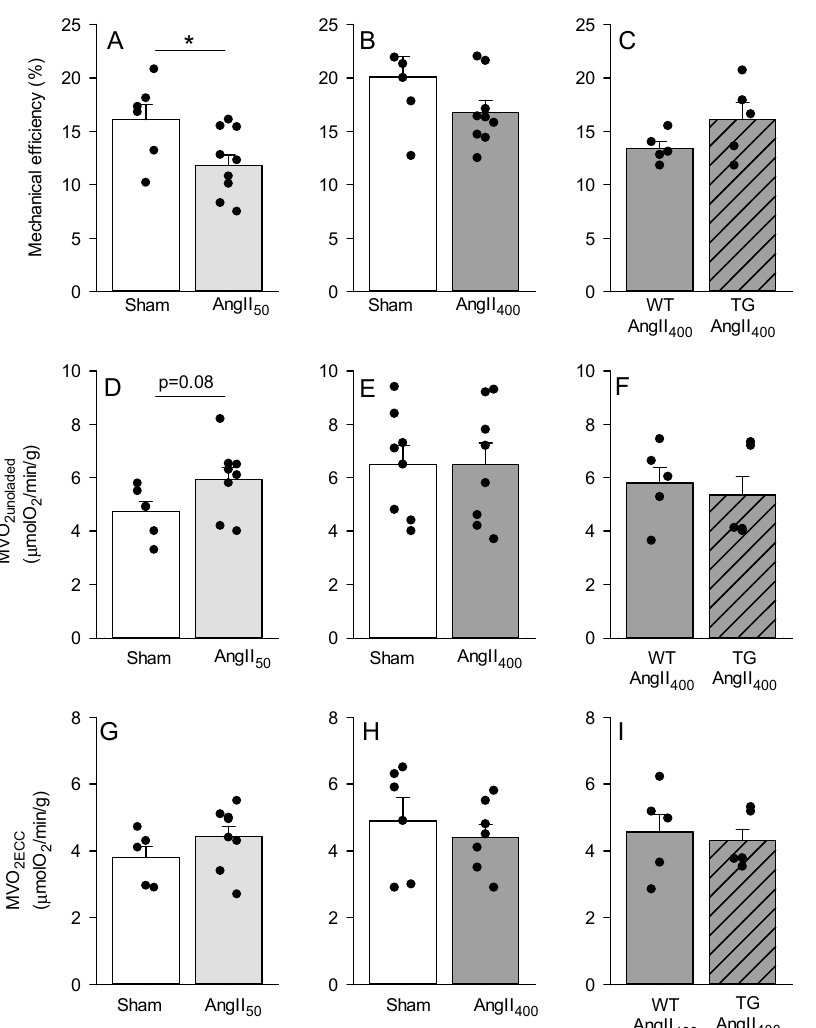
Figure 1. Mechanical efficiency ( A–C ), myocardial oxygen consumption in mechanically unloaded hearts (MVO 2unloaded , D–F ) and MVO 2 for processes associated with excitation-contraction coupling (MVO 2ECC , G–I ), measured in isolated perfused hearts from C57BL/6J, wild-type (WT), and csNOX2 transgenic (TG) mice treated for two weeks with micro-osmotic pumps containing either saline (sham), 50 or 400 ng/kg/min angiotensin II (AngII 50 and AngII 400 ). The data are presented as mean ± SEM. * p < 0.05 vs sham.